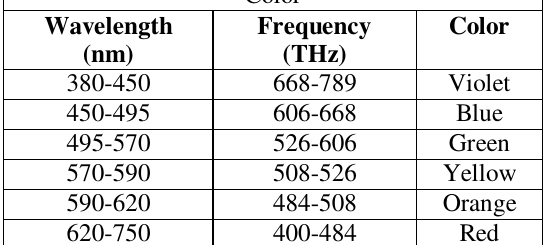
Table 1: Light Wavelengths and Frequency by